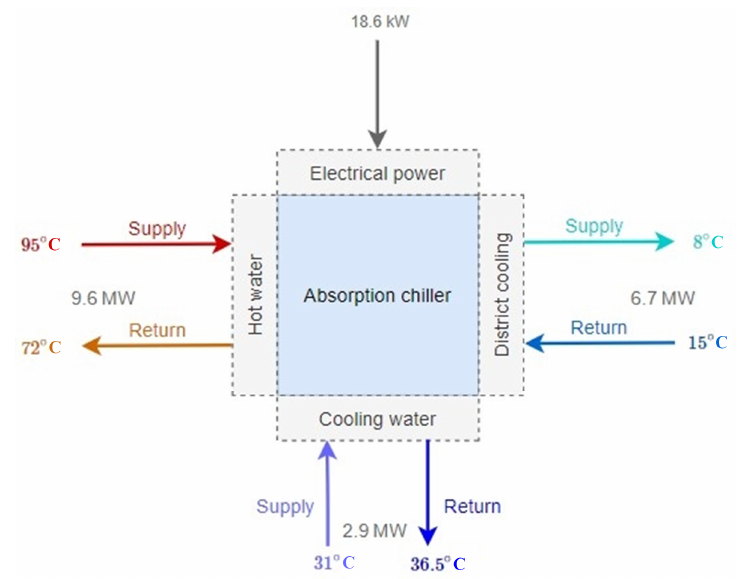
Figure 6. Hourly averaged ambient temperature and solar irradiation in Esbjerg throughout 2018.